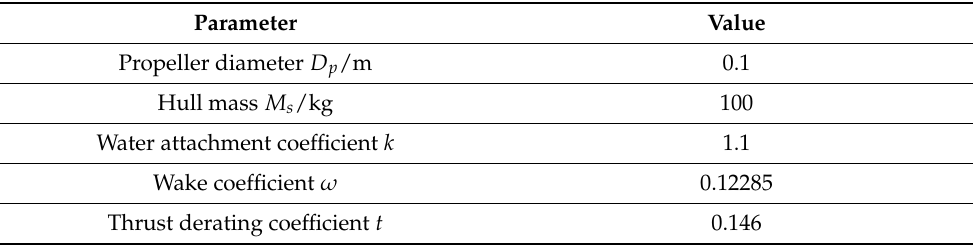
Figure 22. Rotor position observation errors (with propeller load). Table 2. Main parameters of